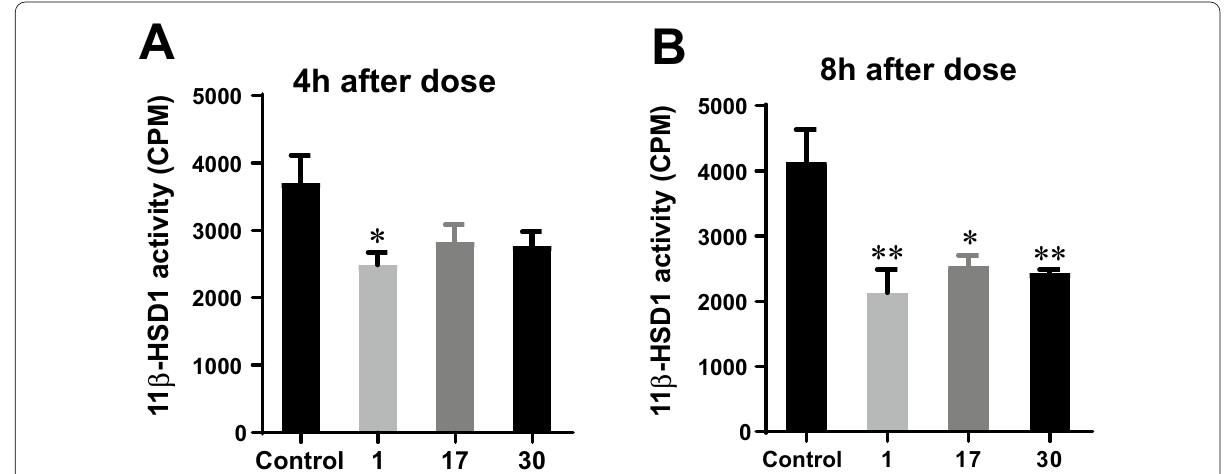
Fig. 5 Inhibitory activities of 1 , 17 and 30 against 11 β ‑HSD1 in livers of ob / ob mice. (n